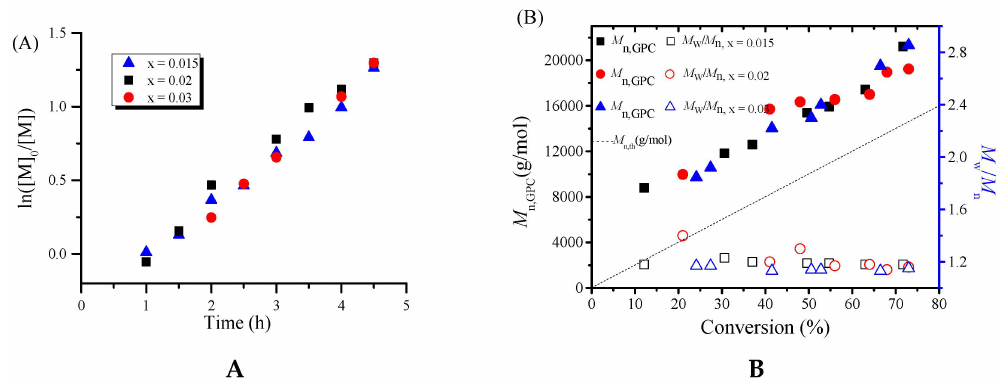
Figure 1. ln([M] 0 /[M]) as a function of time ( A ) and evolution of number-average molecular weight ( M n,GPC ) and molecular weight distribution ( M w / M n ) versus conversion ( B ) for ICAR ATRP of MMA with various iron catalyst concentration. Polymerization conditions: [MMA] 0 :[EBPA] 0 :[Fe(acac) 3 ] 0 :[PPh 3 ] 0 :[ACHN] 0 = 200:1: x :0.3:1 ( x = 0.015, 0.02, 0.03), V MMA = 1.0 mL, V toluene = 1.0 mL, T = 90 ˝ C.